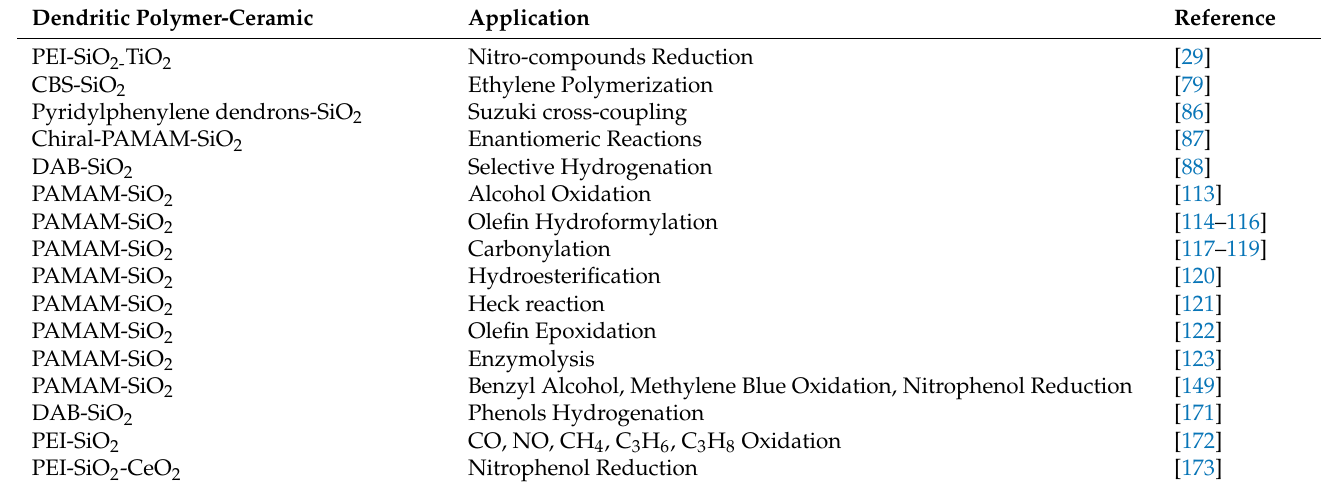
Table 2. Applications of ceramics/dendritic polymer composites in catalysis. Dendritic